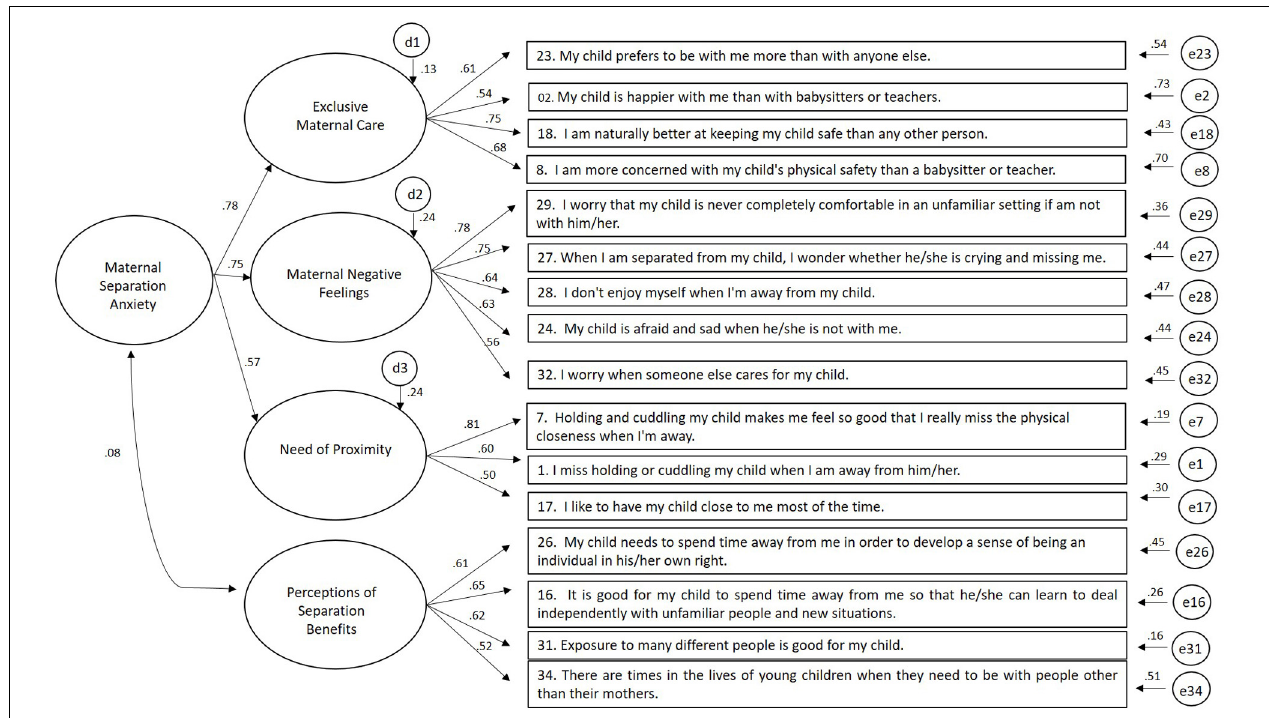
FIGURE 2 | Standardized parameters of the second-order model of the Maternal Separation Anxiety Scale